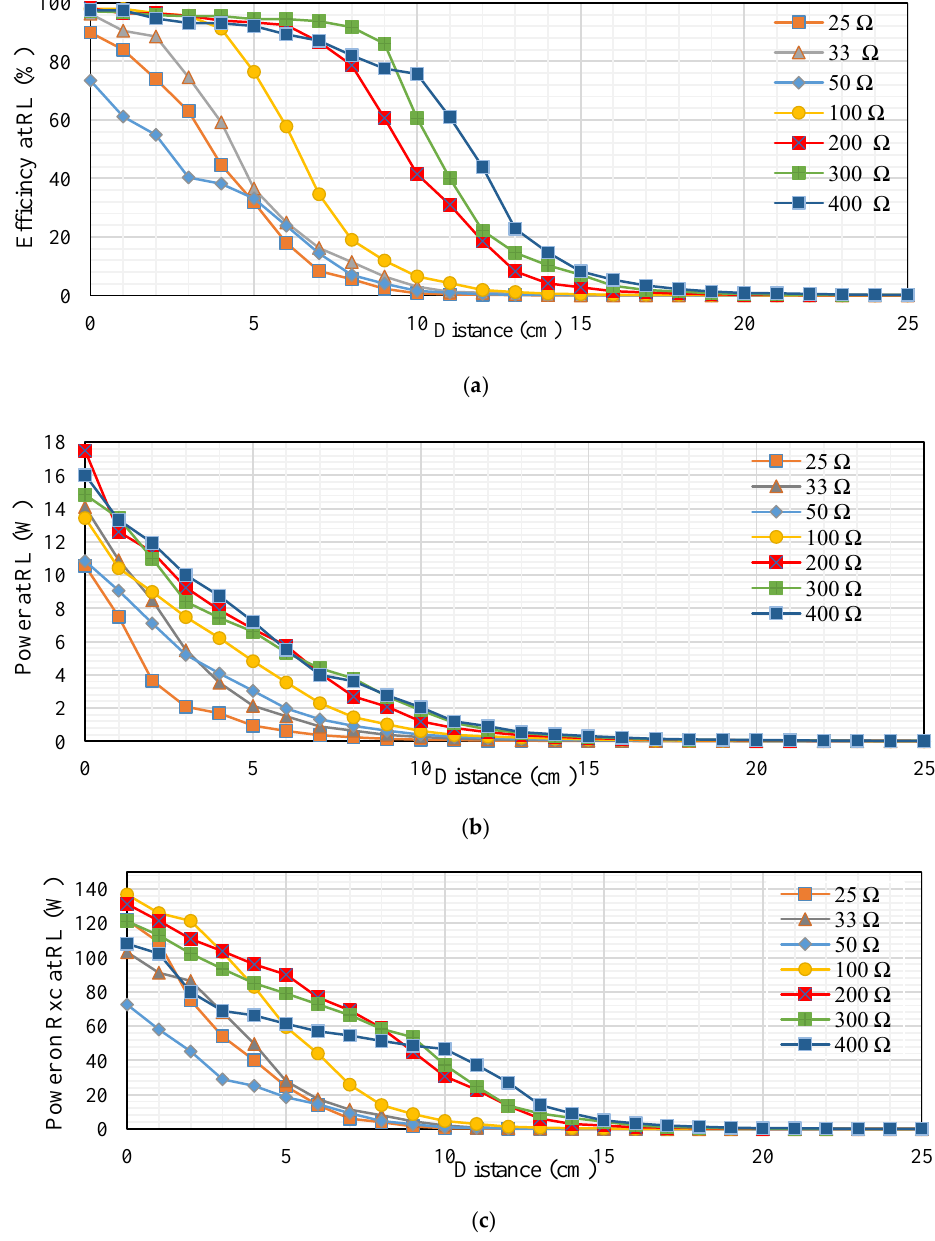
Figure 14. Performance at different loads for second topology: ( a ) transfer efficiency at RL, ( b ) transfer power at RL, and ( c ) transfer power on Rx C at RL.